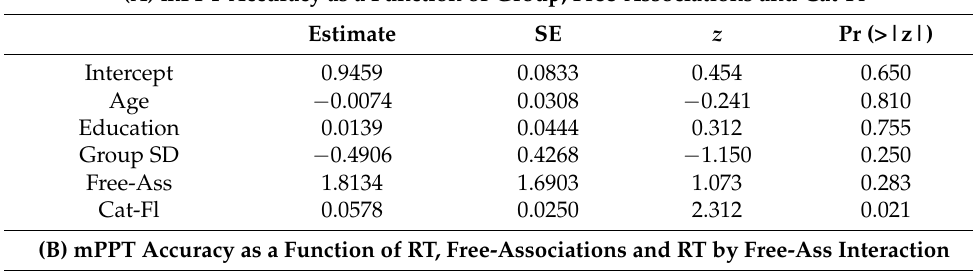
Table 3. Coefficients for mixed effects model examining mPPT, taking multiple predictors simultane- ously into